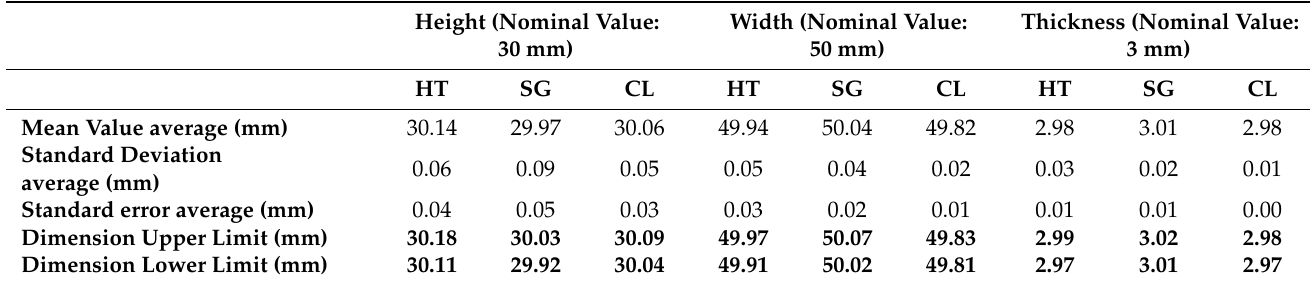
Table 1. Tolerance analysis for resin selection for hybrid material formulation development. HT: High Temperature, SG: Surgical Guide, CL: Clear by Formlabs.